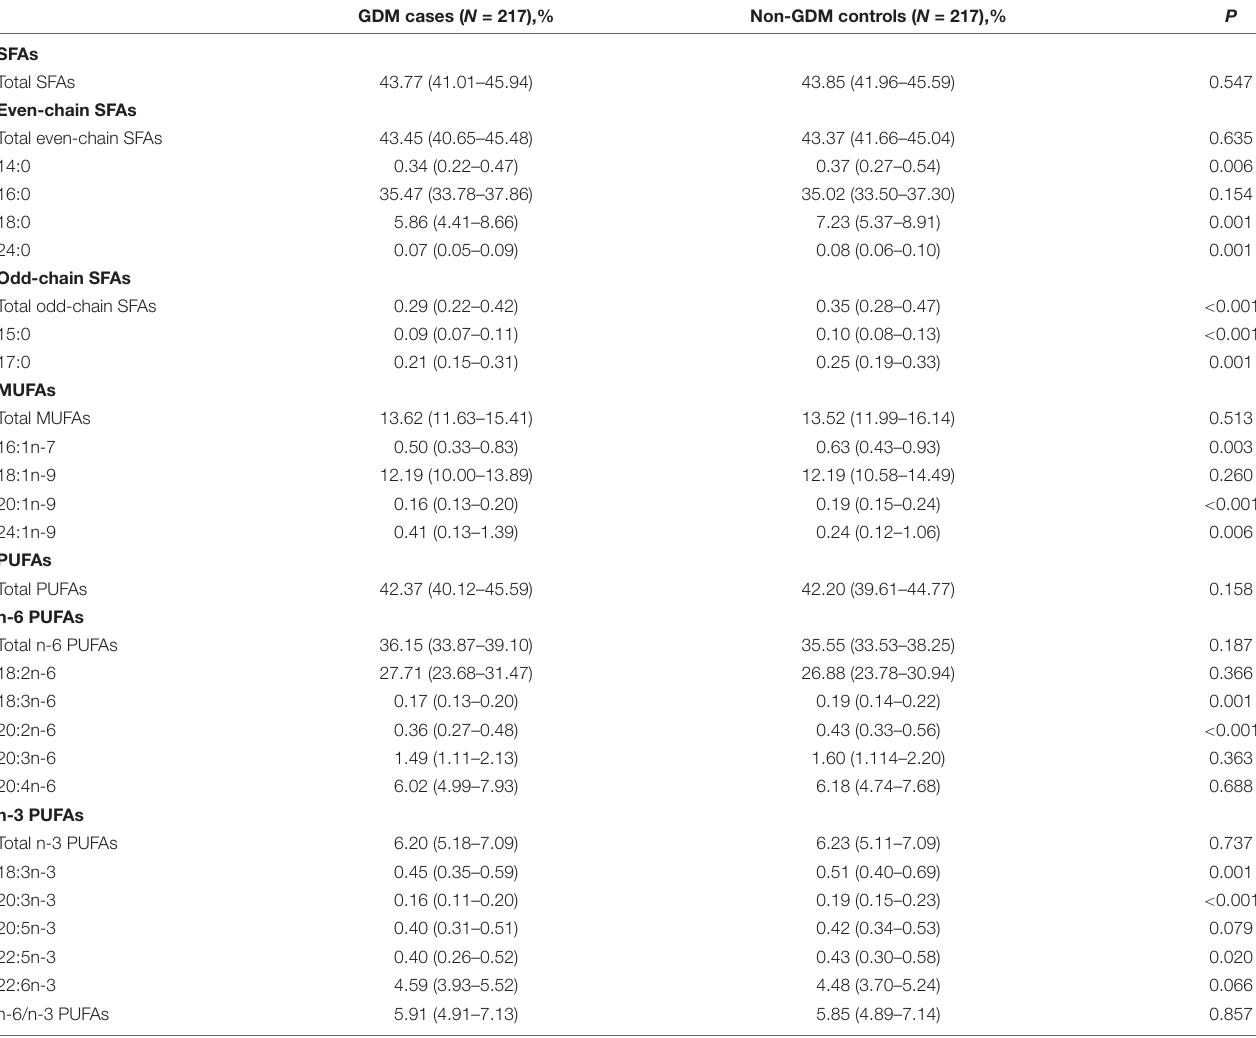
TABLE 2 | Composition (mol% of total fatty acids) of plasma fatty acids among GDM cases and non-GDM controls. GDM cases ( N = 217),% Non-GDM controls ( N = 217),%